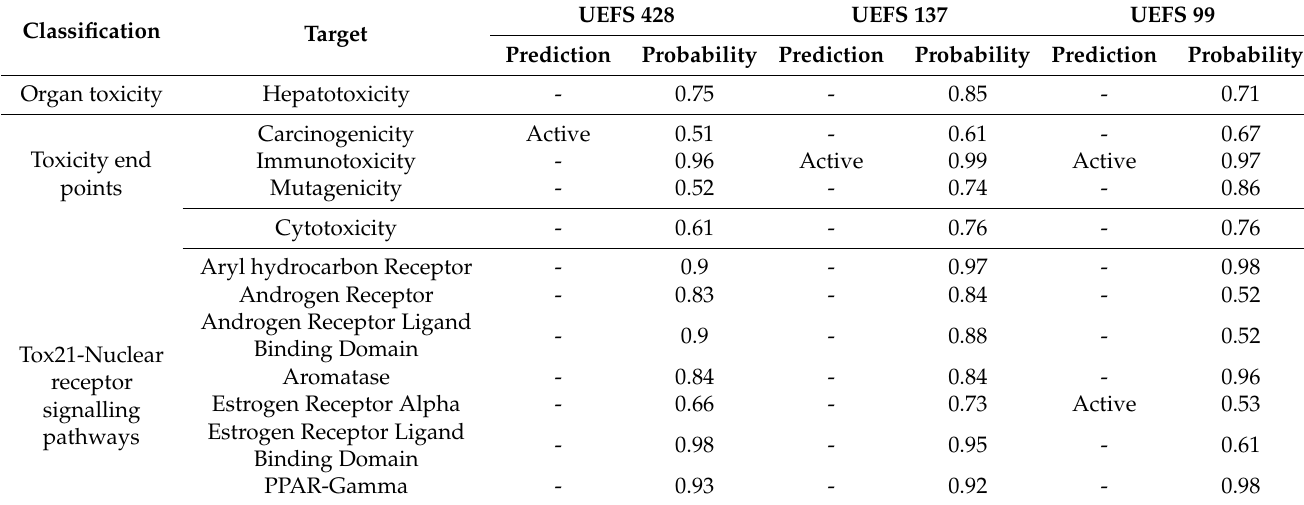
Table 3. Toxicity prediction of top 3